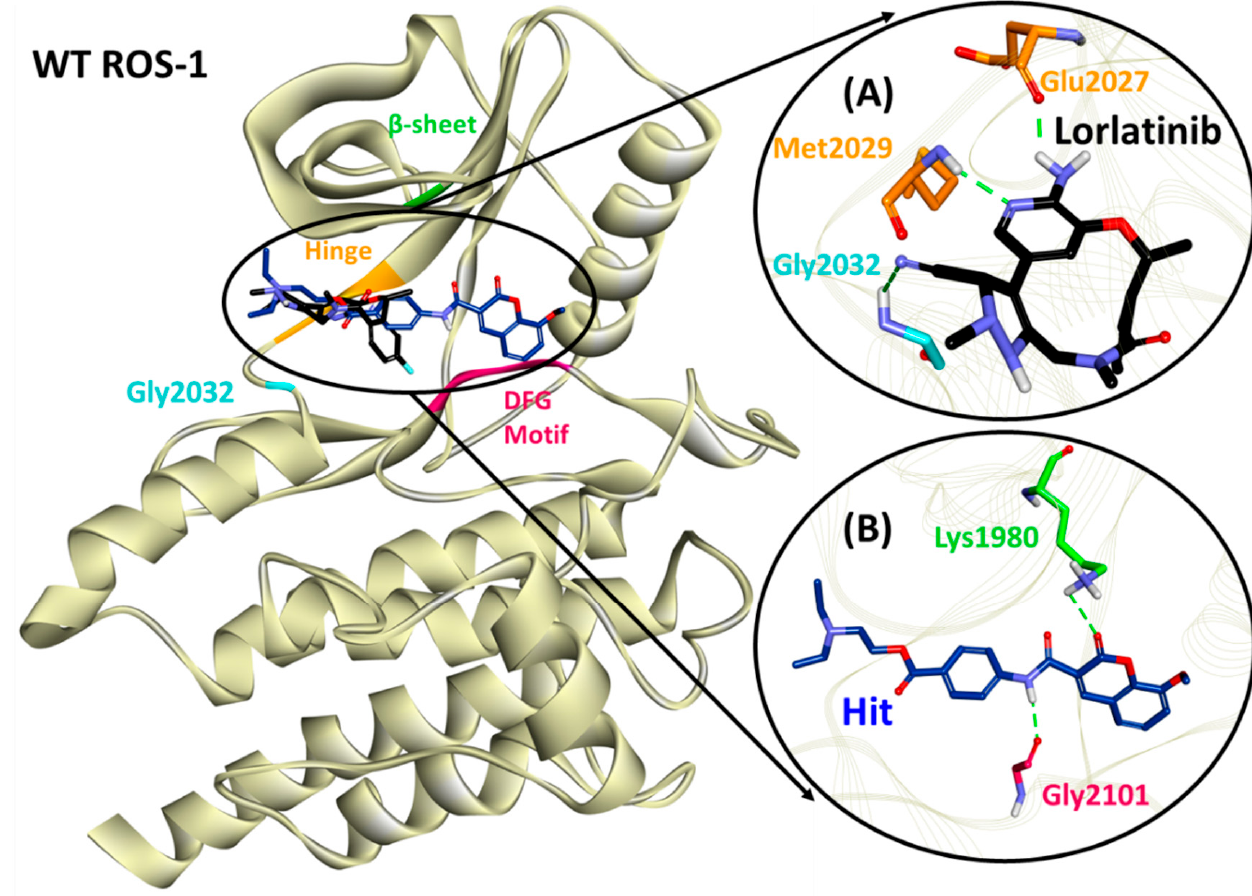
Figure 5. Binding mode of ( A ) lorlatinib and ( B ) Hit compound in the wild type (WT) ROS-1 catalytic pocket and molecular interactions with key residues.